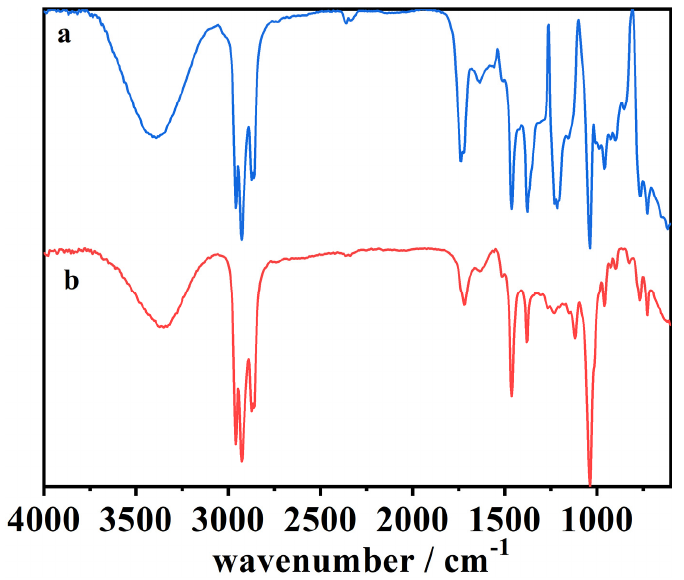
Figure 9. The ATR-FTIR spectra of ( a ) the organic phase of the blank cork bio-oil acidic emulsion, not subjected to electrolysis, and ( b ) the organic phase of the acidic emulsion after Electrolysis VI. (Catholyte: acidic emulsion; Anolyte: alkaline emulsion).